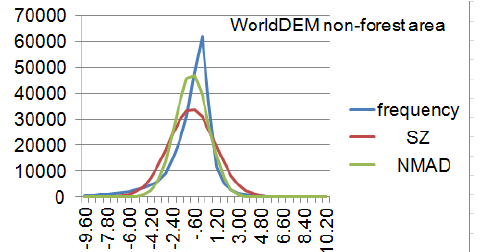
Fig. 19: Frequency distribution of WorldDEM against LiDAR – limited to non-forest area